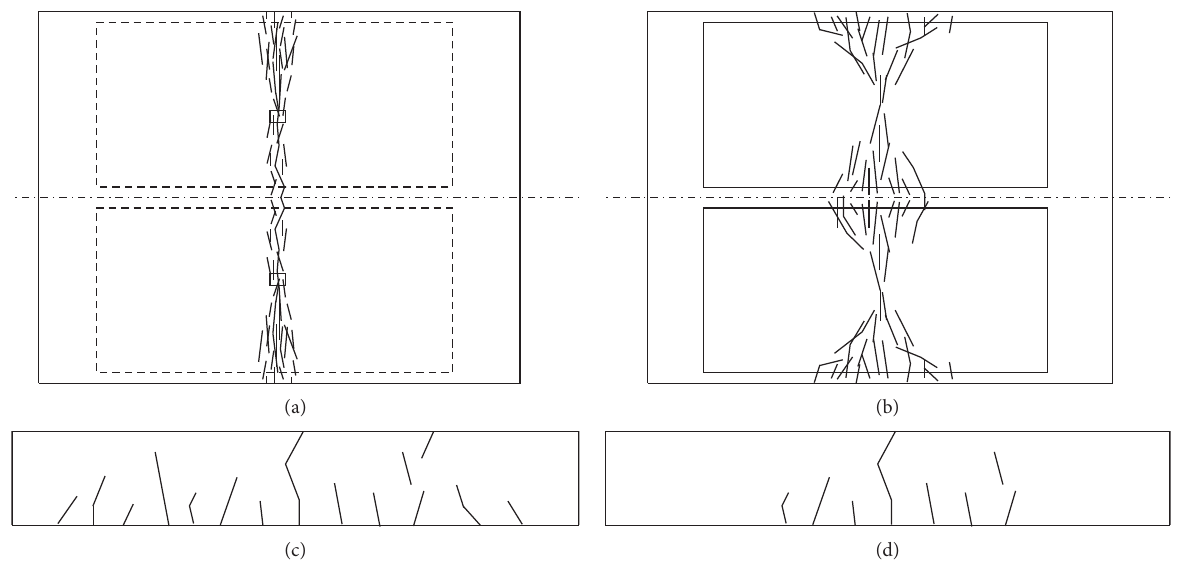
Figure 7: Crack distribution diagrams. (a) Crack distribution on the top surface. (b) Crack distribution on the bottom surface. (c) Crack distribution on the bottom rib. (d) Crack distribution on the bottom edge.